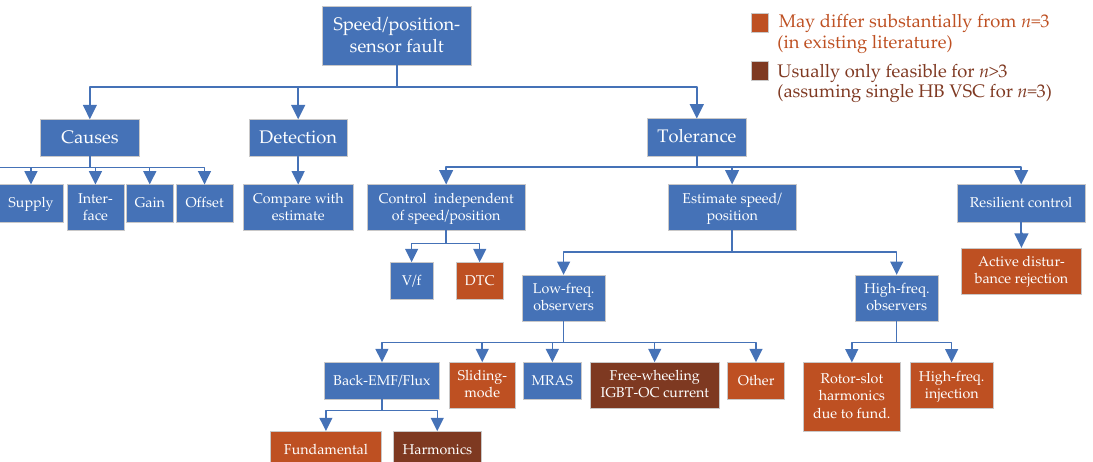
Figure 19. Causes, detection methods, and tolerance approaches for speed/position-sensor faults in multiphase